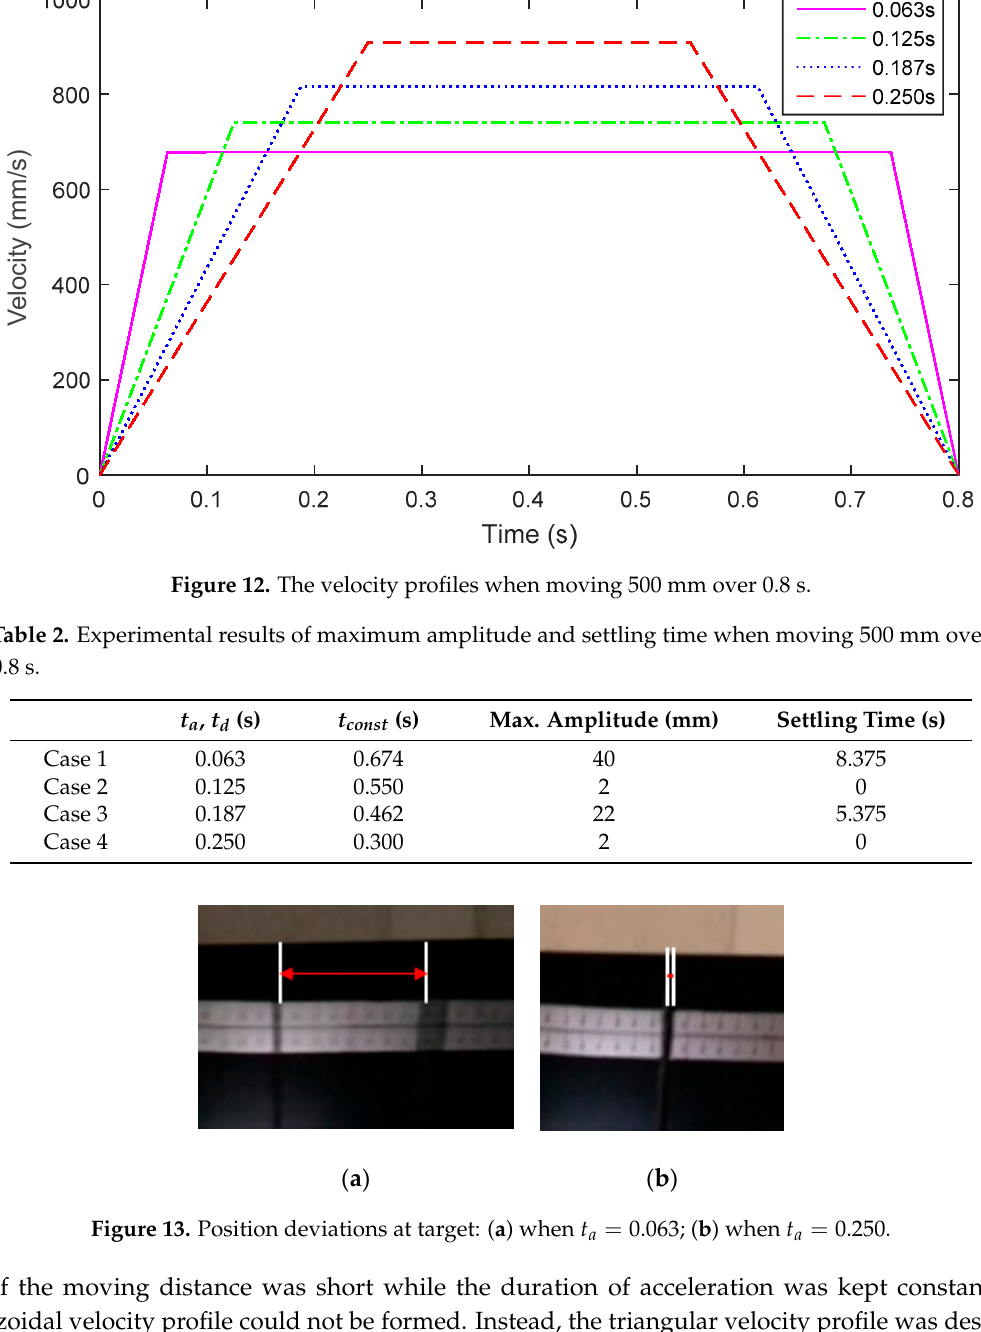
Figure 14. The velocity profiles when moving a short distance with a maximum velocity of 1000 mm/s. Table 3. Experimental results for maximum amplitude and settling time when moving a short distance with a maximum velocity of 1000 mm/s. 𝒕 𝒂 , 𝒕 𝒅 (𝐬) Distance (mm)